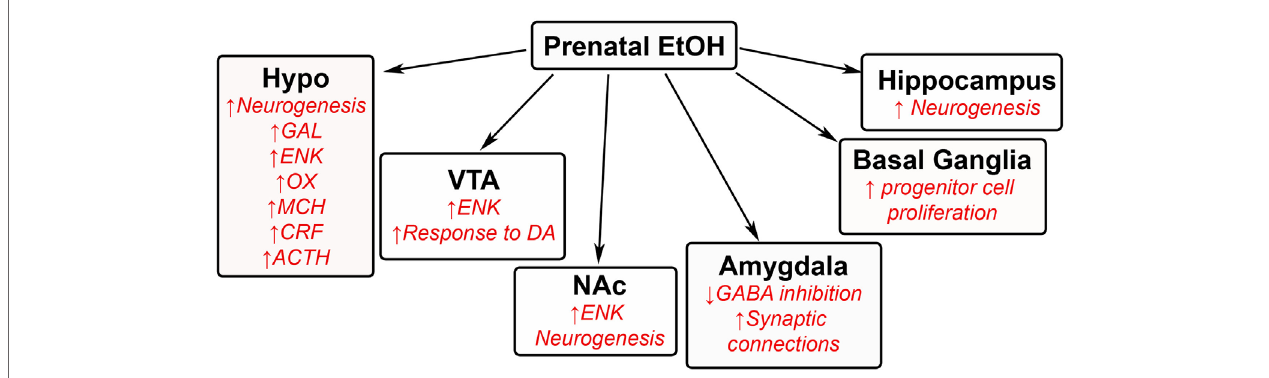
FiGURe 4 | effects of prenatal ethanol exposure on offspring brain . A schematic summarizing some of the changes that occur in the brains of offspring after being exposed to low levels of ethanol during gestation. GAL, galanin; ENK, enkephalin; OX, orexin; MCH, melanin-concentrating hormone; CRF, corticotrophin releasing factor; ACTH, adrenocorticotropic hormone; DA, dopamine; GABA, γ -aminobutyric